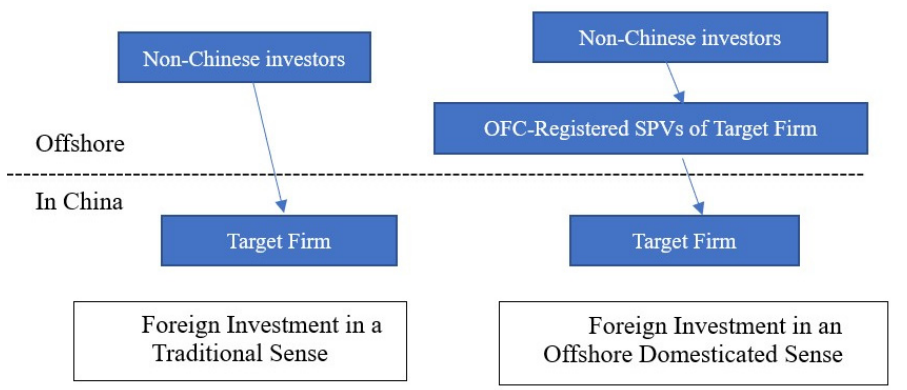
Figure 1. Traditional and Transformed Understandings of Foreign Capital Inflow. Source: The Author’s Conceptualization.